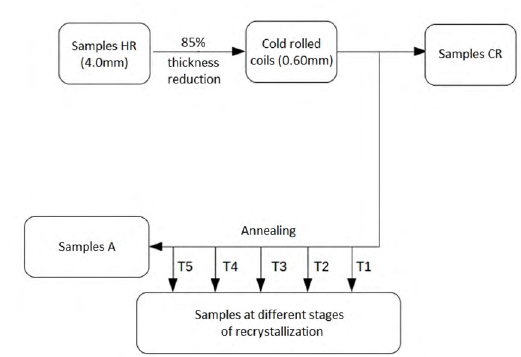
Figure 1. Thermo-mechanical processing scheme.